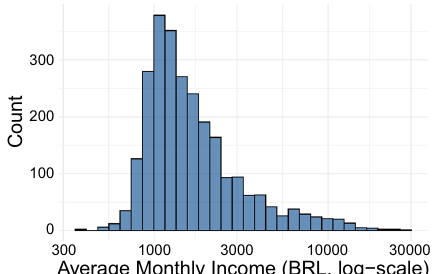
Fig. 2 Distribution of average income per capita (Brazilian Real per month) across hexagon cells